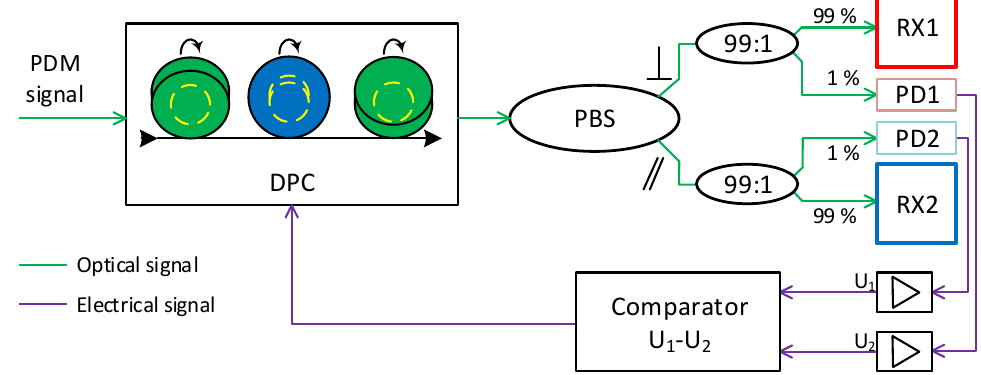
Figure 9. Block scheme of the dynamic polarization controller. The input polarization multiplexed signal goes through the DPC to the PBS. The demultiplexed signal goes through the coupler with a division ratio of 99:1, where 99 % of the signal goes to receivers RX1 and RX2 and 1 % goes to monitoring photodiodes PD1 and PD2. The optical signal is converted to an electrical signal and amplified. The electronic comparator compares the voltage levels of both photodiodes PD1 and PD2 and regulates the DPC via servo-engines that rotate polarization by wave plates. The control signal from the comparator provides feedback that maintains the polarization in an ideal setup. The described system is independent of the bit rate and the modulated formats utilized. The next advantage is that the system does not need to interrupt the distribution network, transmitters, receivers and many other components used on optical links [3]. Optical signals with orthogonal polarization TX1 and TX2 could be generated by one laser diode or by two different diodes that transmit on the same wavelength. Both signals are multiplexed by a polarization multiplex. During the transmission of the multiplexed signal in the optical fiber, the state of polarization is changed from linear to